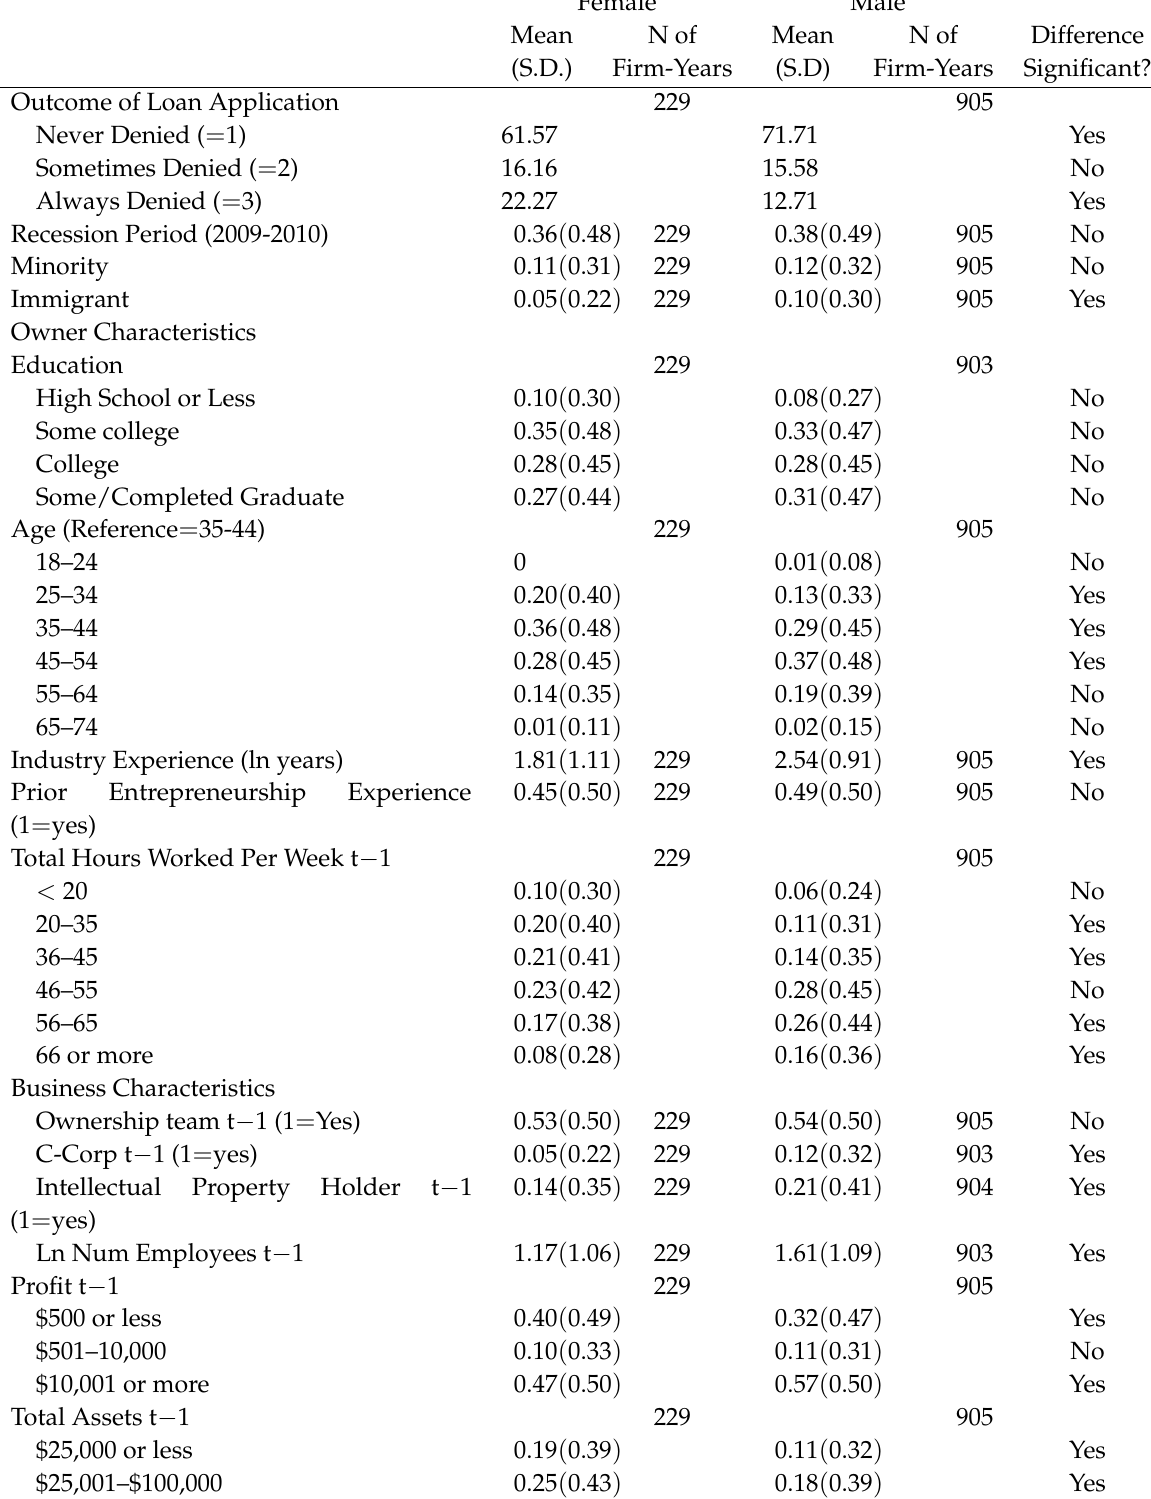
Table 1: Characteristics of Firms Reporting Loan